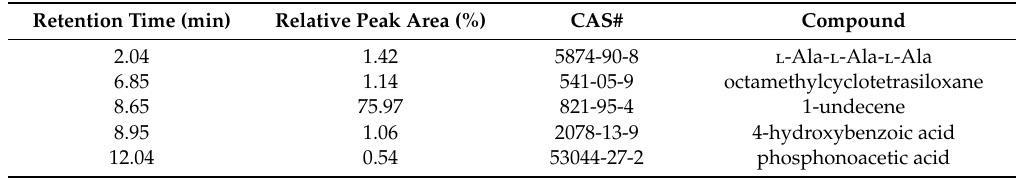
Figure 5. Chromatographic profiles of the volatile organic compounds (VOCs) of ( A ) strain ST–TJ4 incubated for 48 h in LB medium and ( B ) uninoculated LB medium. Table 3. GC-MS / MS volatile profile of strain